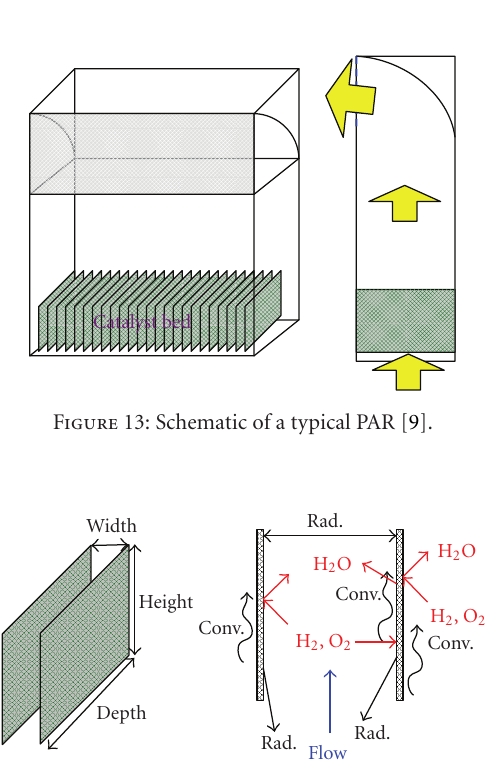
Figure 14: Physics phenomena in the catalyst flow channel